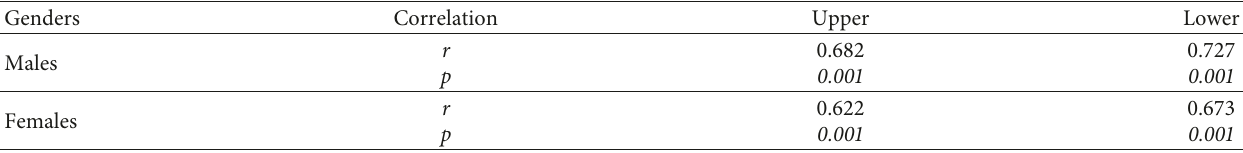
Table 2: Correlation among the measured variables.